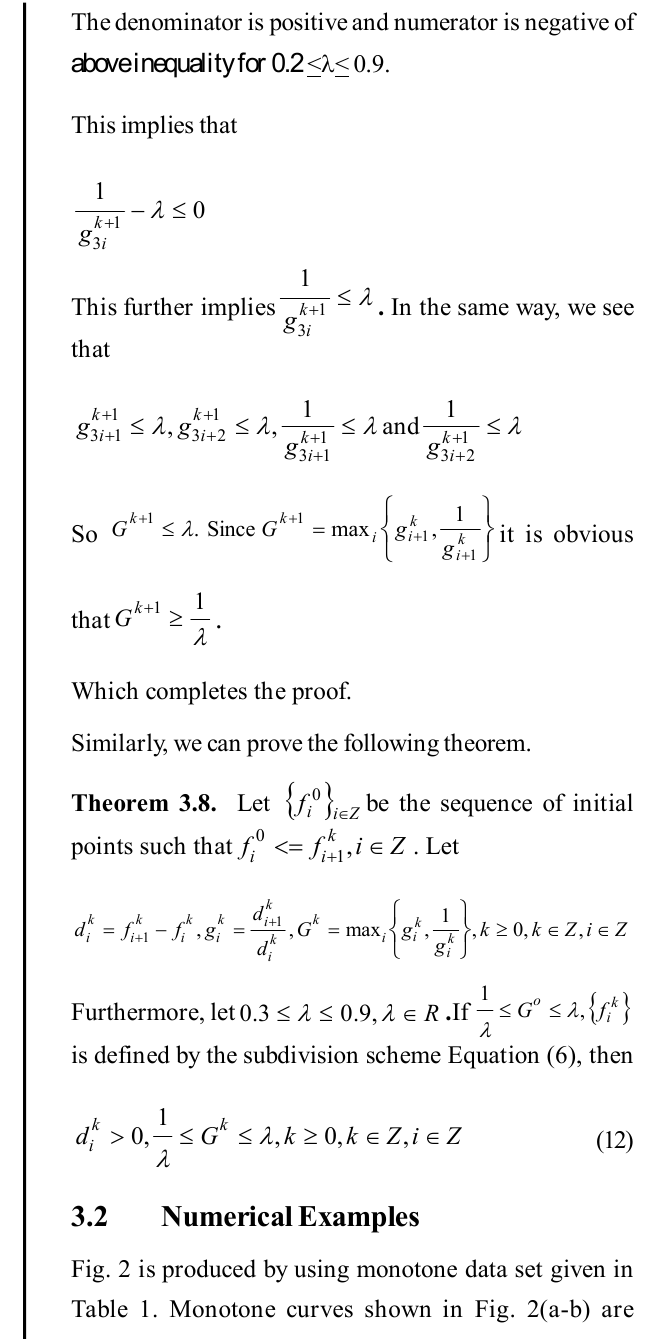
Fig. 2 is produced by using monotone data set given in Table 1. Monotone curves shown in Fig. 2(a-b) are produced by the schemes Equations (5-6) respectively. In Fig. 3, the initial control polygons are shown by dotted lines and solid lines show the limit curves. Limit curves presented in Fig. 3(a-b) and Table 2 are obtained by proposed schemes Equations (5-6)